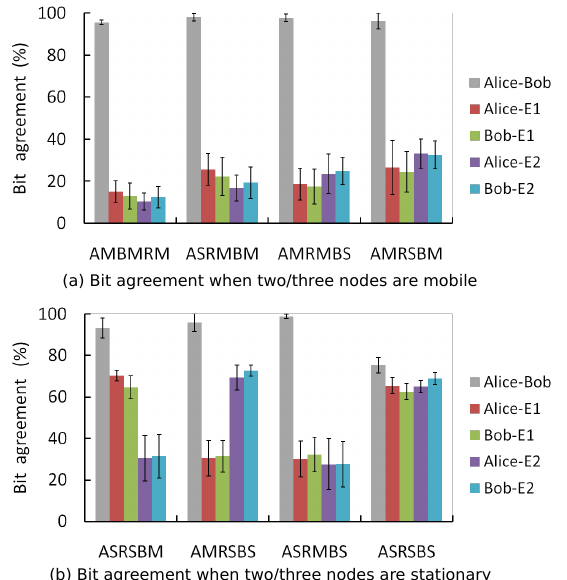
is too low compared to Alice and Bob, which indicates that not much useful secret key bit information can be obtained when all nodes are